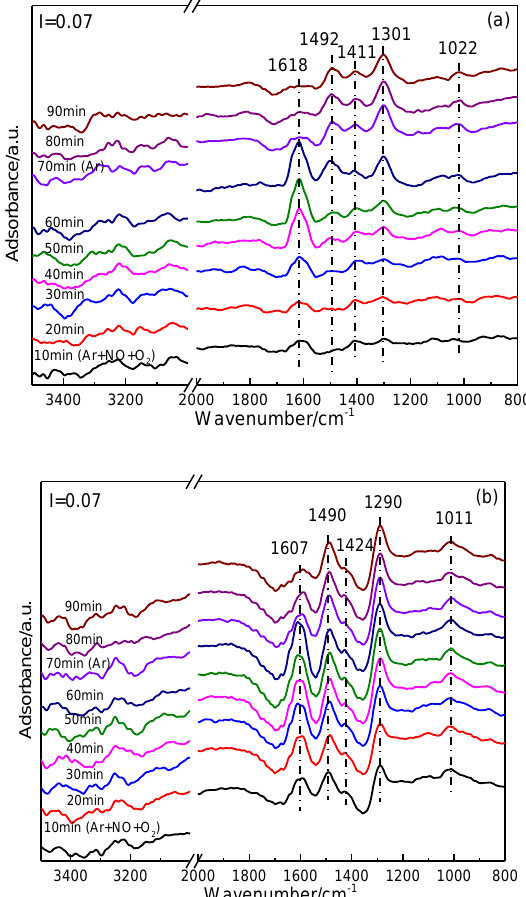
Figure 7. DRIFT spectra of SOC ( a ) and SSOC ( b ) exposed to 1000 ppm NO and 15% O 2 at 300 ˚ C for a different time. di ff erent